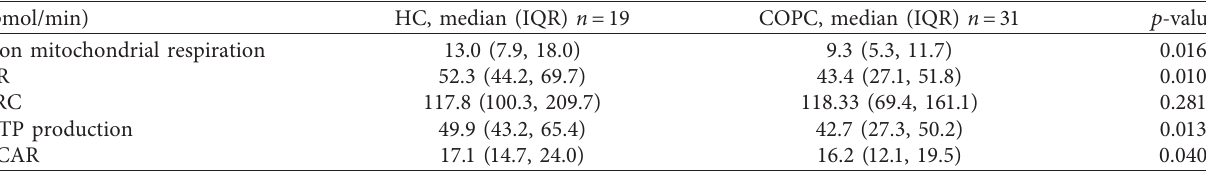
Table 1: Comparison in mitochondrial bioenergetic between healthy controls and youth with chronic overlapping pain conditions.